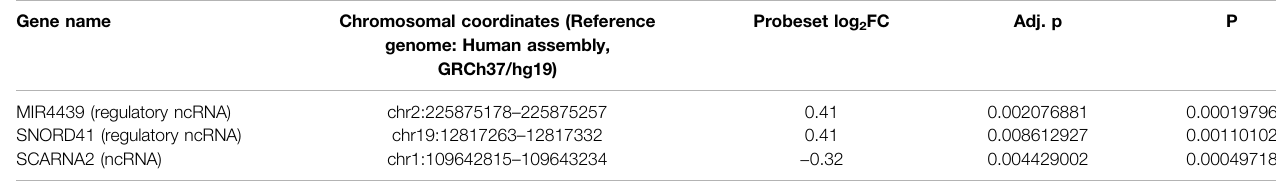
TABLE 3 | TDE small and classical non-coding RNAs (ncRNAs) in normal pregnancy. p -values and fold changes of timecourse differentially expressed [TDE] ncRNA transcripts are shown. Chromosomal coordinates (Reference genome: Human